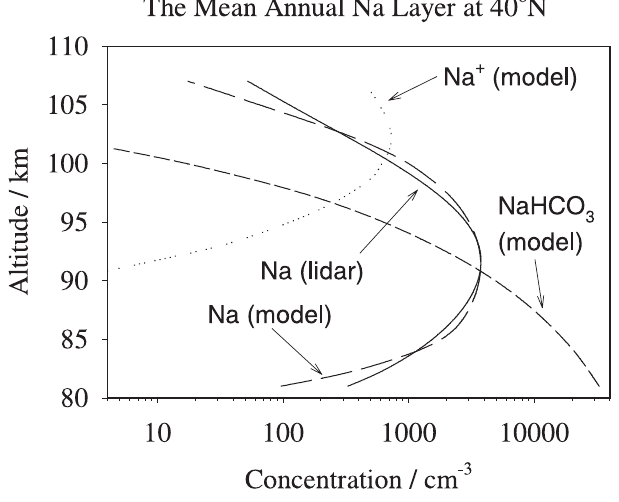
Fig. 2. Annual mean profiles of Na, Na + and NaHCO the UEA 1D sodium model at 40 (cid:176) N. The modelled Na layer is compared with the average from a 3-year set of lidar observations (Plane et al